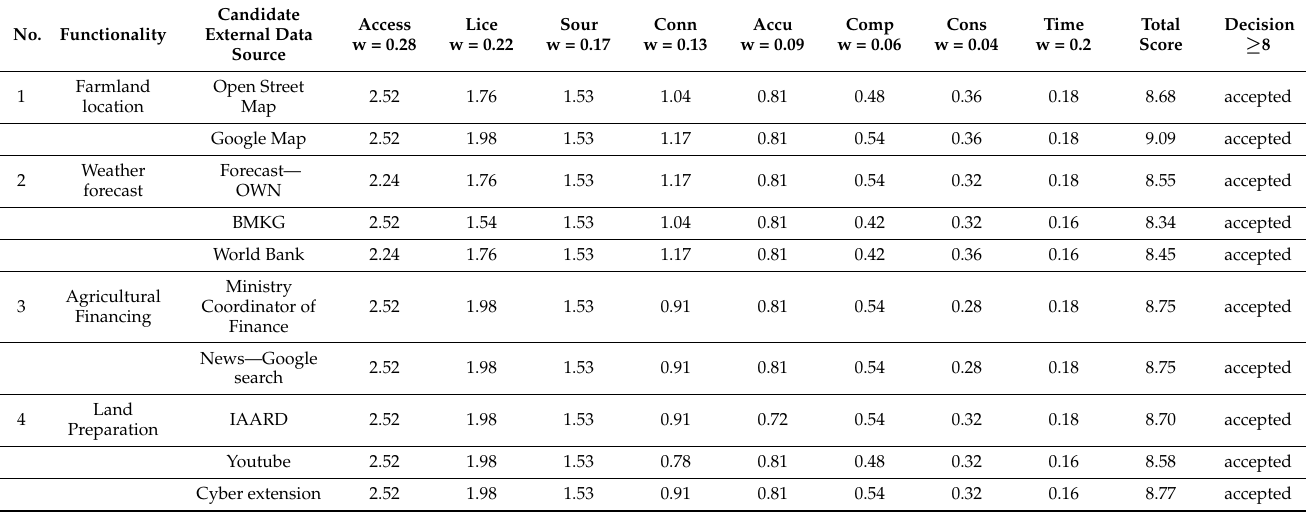
Table A3. Data Quality Assessment Based on Eight Dimensions